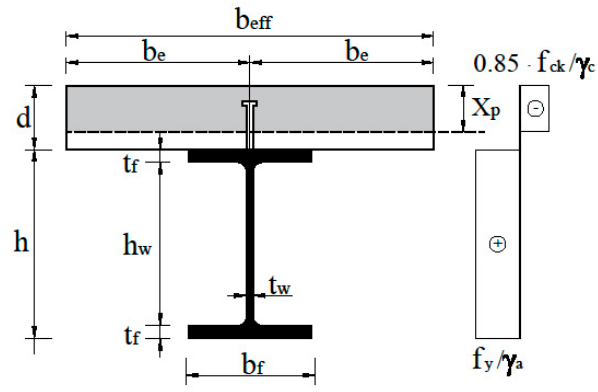
Figure 3. Plastic moment resistance with the neutral axis in the